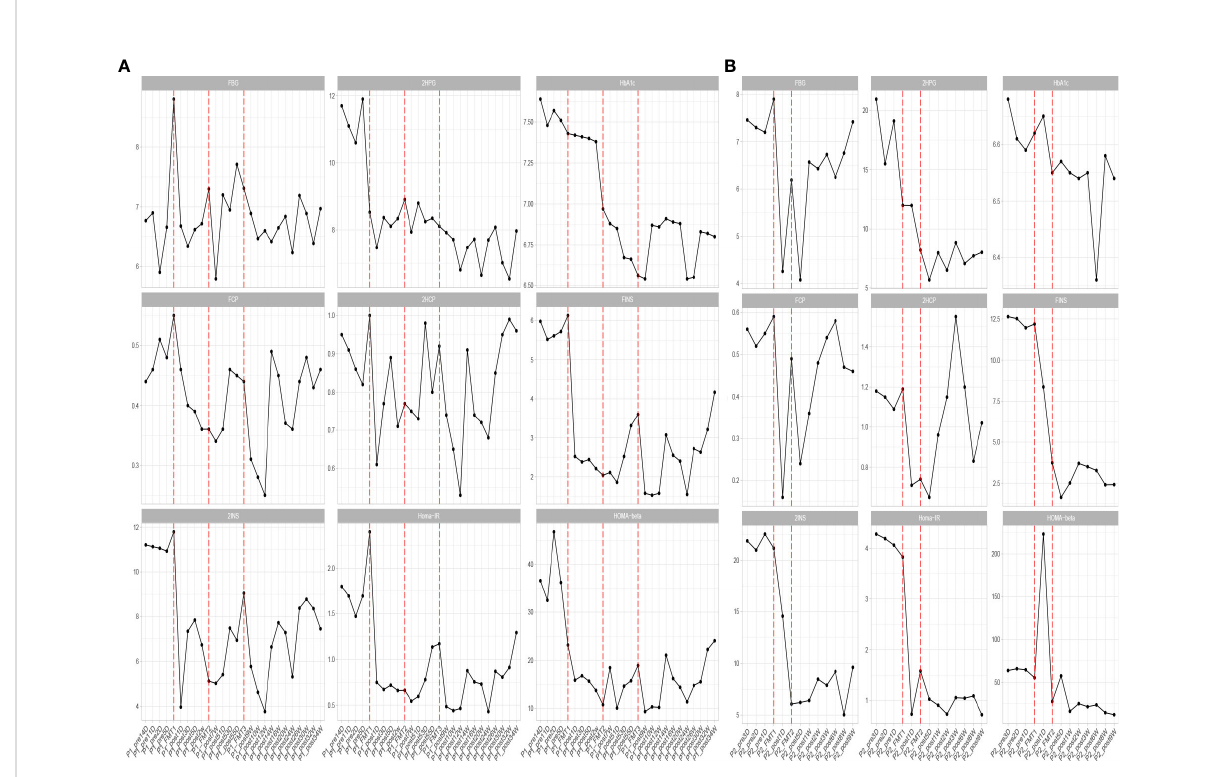
FIGURE 1 Changes in blood glucose before and after transplantation in Patients 1 (A) and 2 (B) . FBG, fasting blood glucose; 2HPG, 2-hour postprandial blood glucose; HbA1c, glycated hemoglobin; FCP, fasting C-peptide; 2HCP, 2-hour postprandial C-peptide; FINS, fasting insulin; 2INS, 2-hour postprandial insulin; Homa-IR, insulin resistance index; HOMA, islet cell function index. The horizontal coordinates in the fi gure indicate the different time points before and after transplantation. The vertical coordinates are the corresponding values of glucose-related clinical indicators at different time